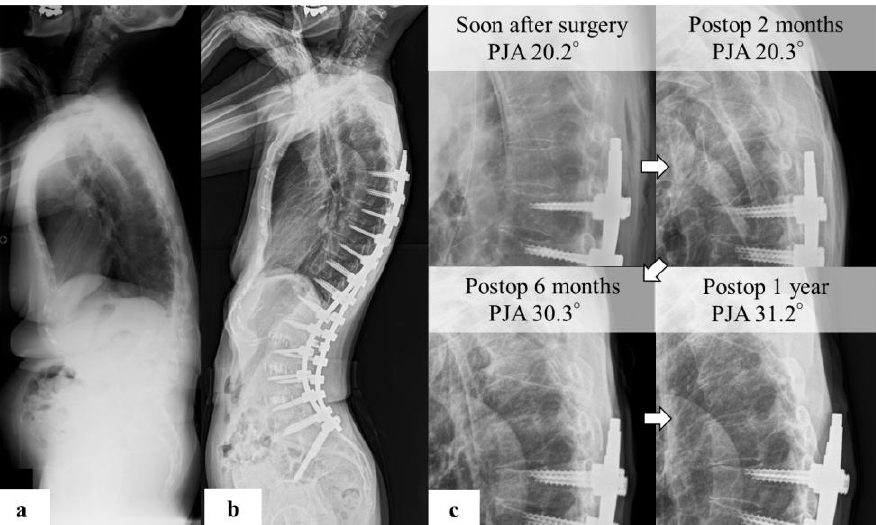
Figure 4. (a) Representative case of PJK preoperative standing X-ray images indicated the following